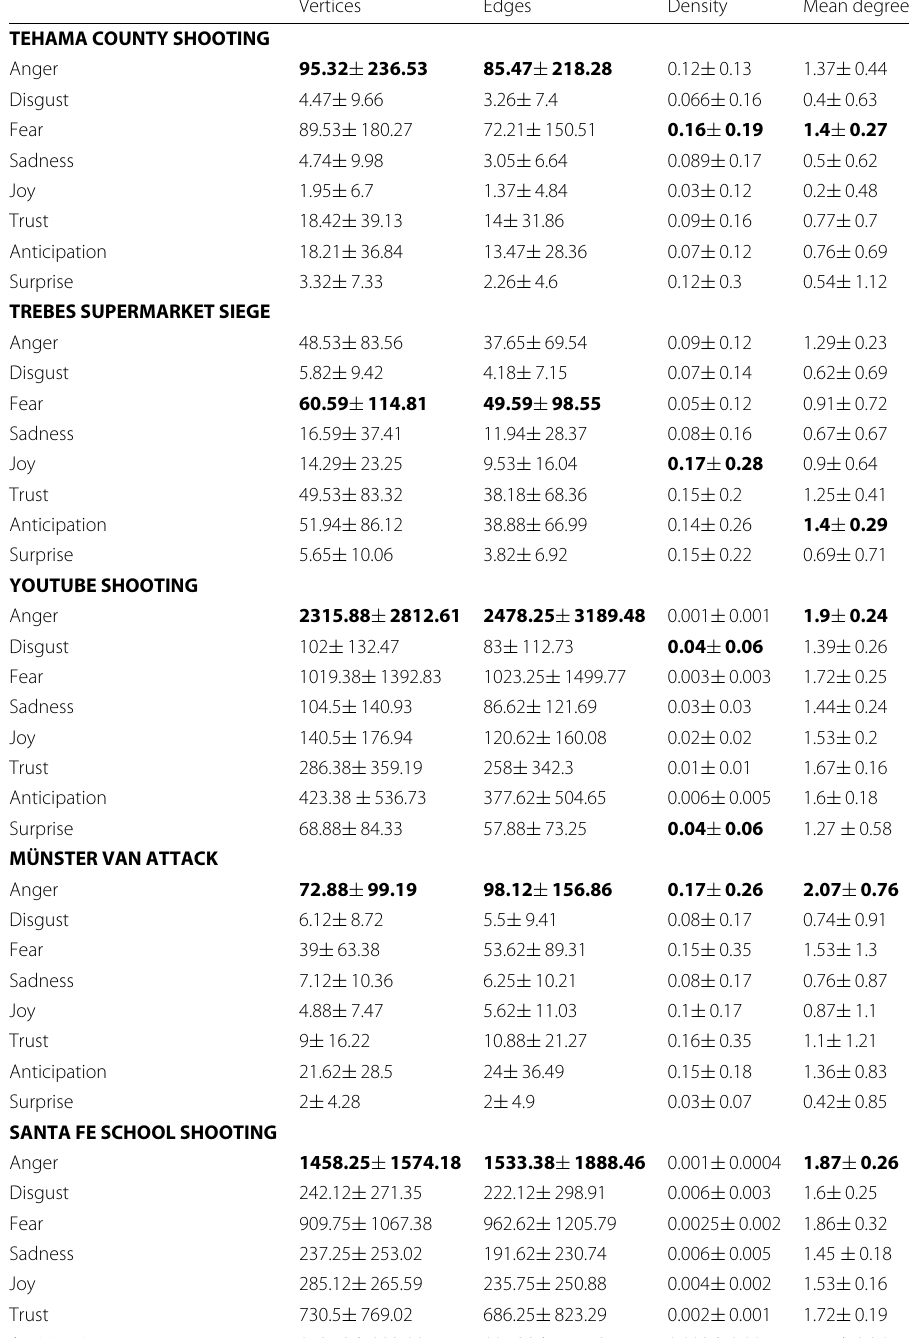
Table 2 summarizes information (mean number and standard deviation of vertices, edges, network density, maximum degree, and mean degree of the vertices) about each layer of our real-world networks averaged over the time-period of data extraction. Table 2 Basic information about each layer in a multiplex network Vertices